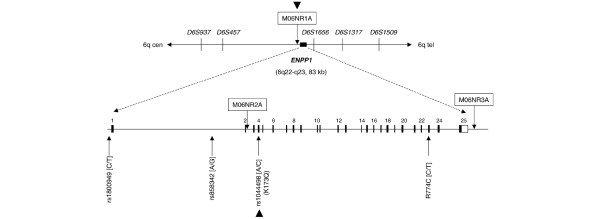
Map of the ENPP1 locus. The 25 ENPP1 exons (boxes) are numbered from left to right according to the direction of transcription. The filled boxes constitute the coding region. The open box represents the long 3' untranslated region. Vertical arrows point to the polymorphic sites analyzed in this study. M06NR1A is located some 46 kilobase pairs (kb) upstream of the promoter. The other intermarker distances may be taken from the graph, which is drawn to scale. DNA markers with alleles that were found to be significantly associated with hand OA (see Tables 3 and 4) are marked by arrowheads.